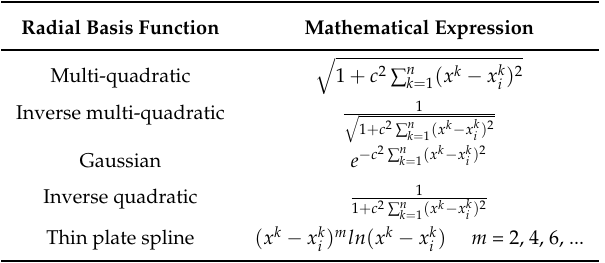
Table 3. Commonly known radial basis